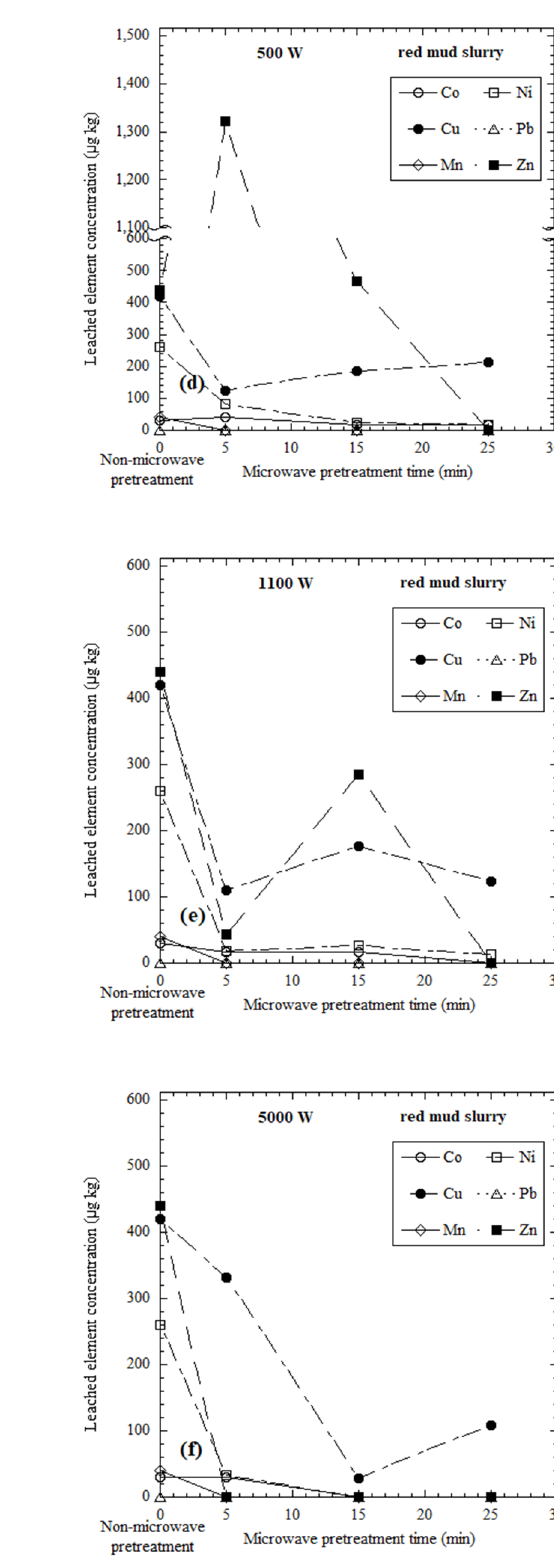
Figure 3. Cr, V, and As leached concentrations at various output powers: ( a ) 500 W, ( b ) 1100 W, and ( c ) 5000 W and Co, Cu, Mn, Ni, Pb, and Zn leached concentrations at various output powers: ( d ) 500 W, ( e ) 1100W, and ( f ) 5000 W from the red mud slurry microwave-pretreated at various output powers.